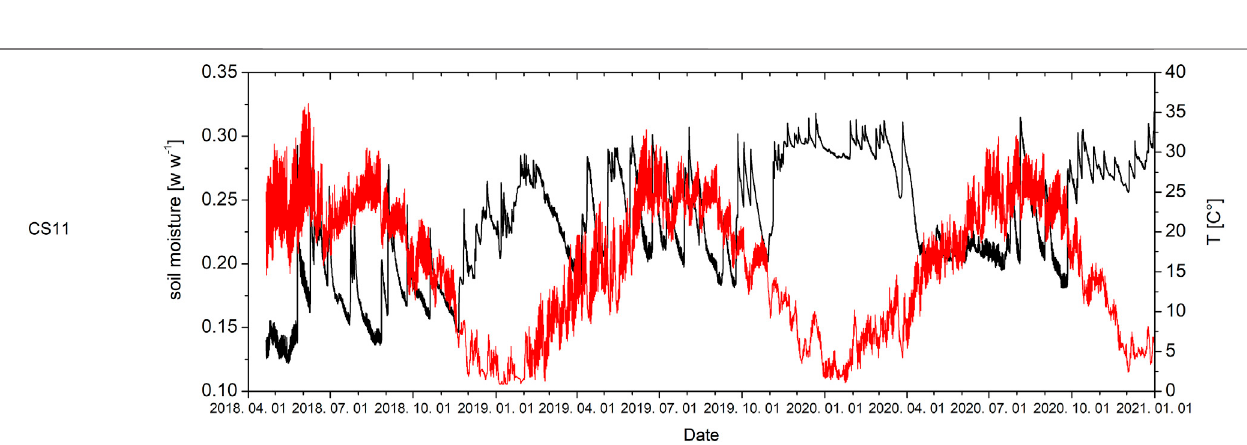
Frontiers in Environmental Science |